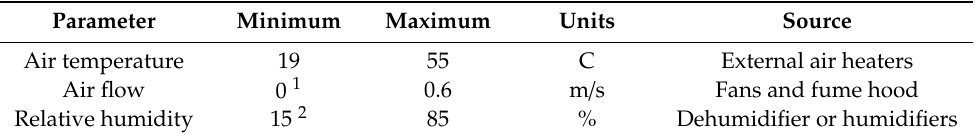
Table A6. Environment parameters controlled by accessory